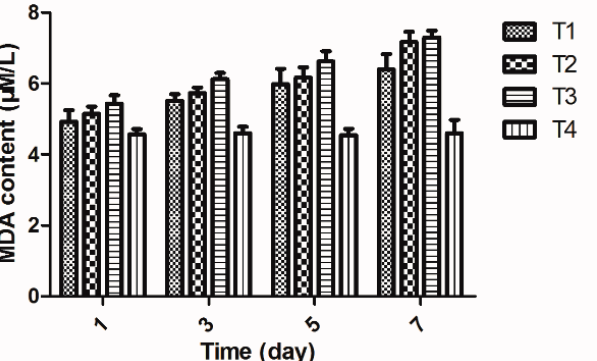
Figure 4. The changes of MDA content in rice (The data presented are the mean ± SD). T1 : Xoo + Compound 2-(methyl sulfonyl)-5-(4-fluorophenyl)-1,3,4-oxadiazole; T2 : Xoo + Bismerthiazol; T3 : Xoo ; T4 : Untreated blank